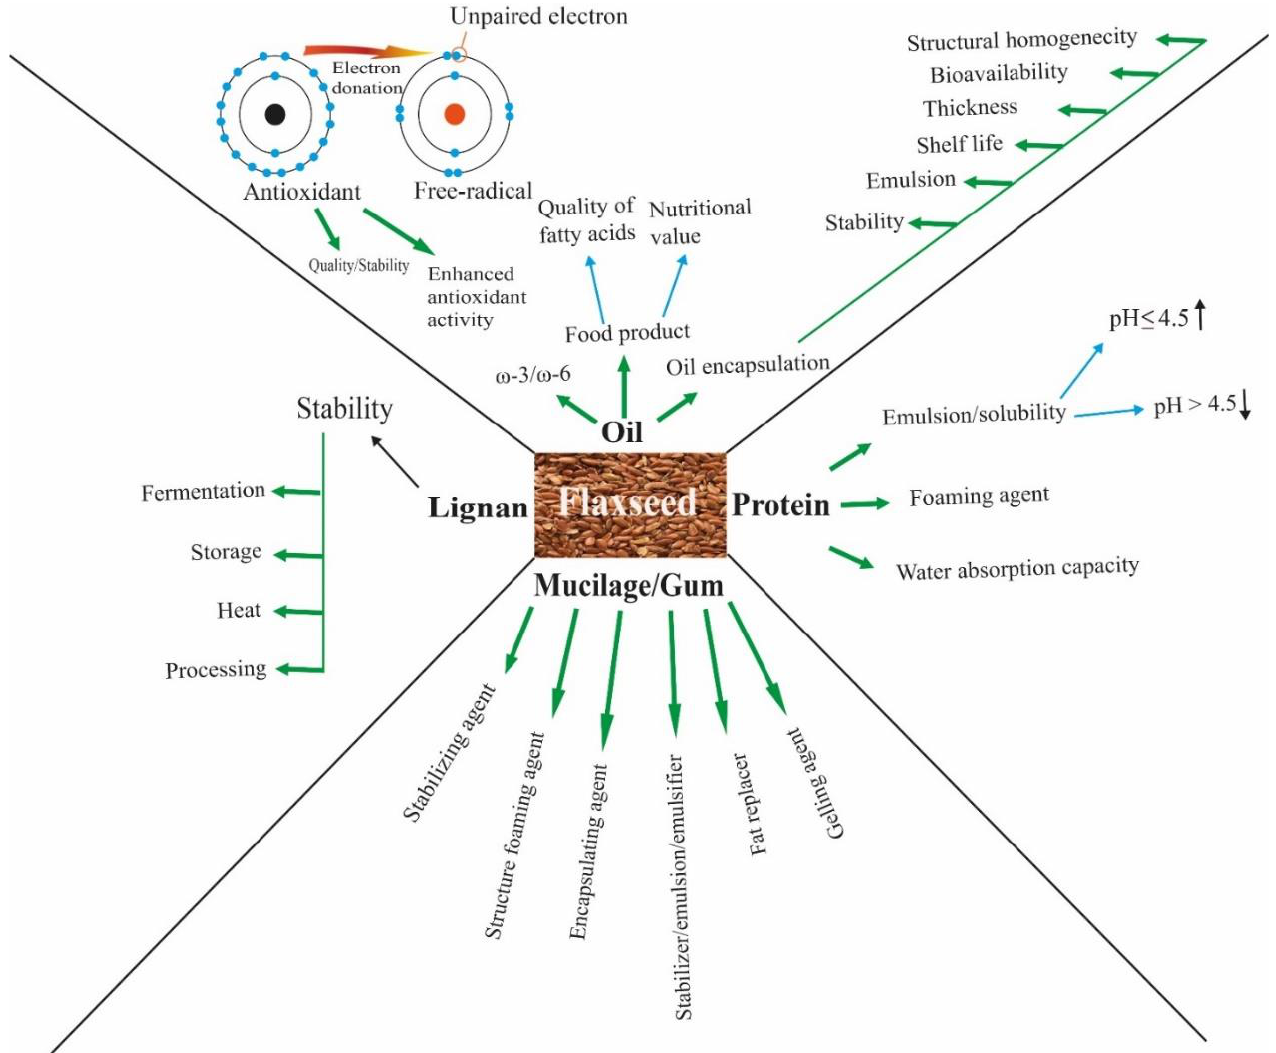
Figure 2. Functional properties of flaxseed bioactive compounds.